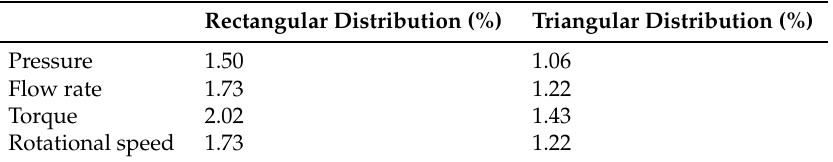
Table 1. Results of uncertainty analysis.